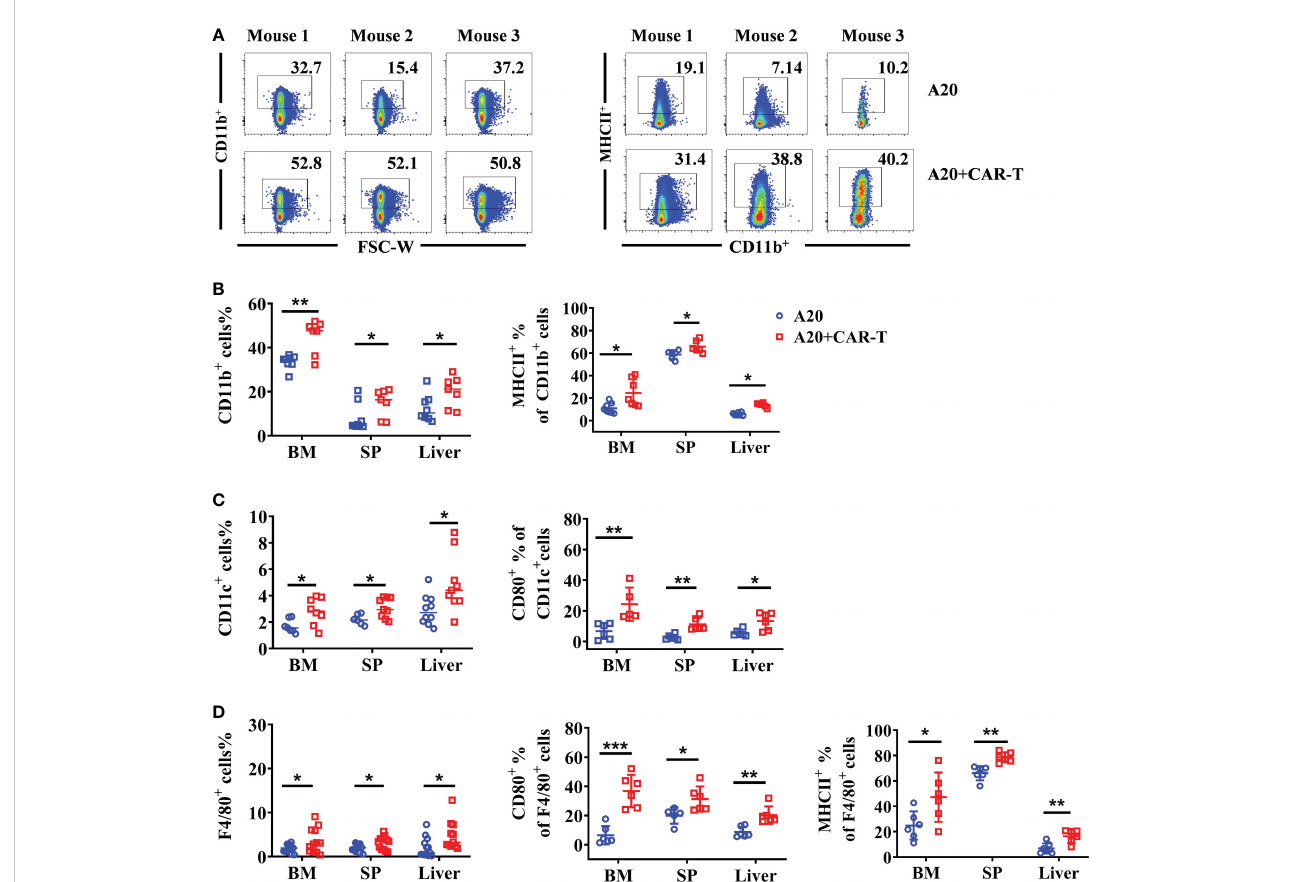
FIGURE 3 The myeloid cells were upregulated and activated in mice that achieved remission. On day 15, the BM, spleen, and liver from the lymphoma model with or without CAR-T cells were harvested. The myeloid cells were labeled with CD11b, CD11c, and F4/80. (A) The fl ow cytometry plot of CD11b+ mouse2 of A20 was corrected (B – D) . The percentage of CD11b + myeloid cells, CD11c + DCs, and F4/80 + macrophages. Then the expression of MHC II and CD80 in different populations were stained and analyzed by fl ow cytometry. Two independent experiments were repeated for (B) and (C) ; Four independent experiments were done for (D) . Data were compared using unpaired Student ’ s t-test. * P < 0.05, ** P < 0.01, *** P <